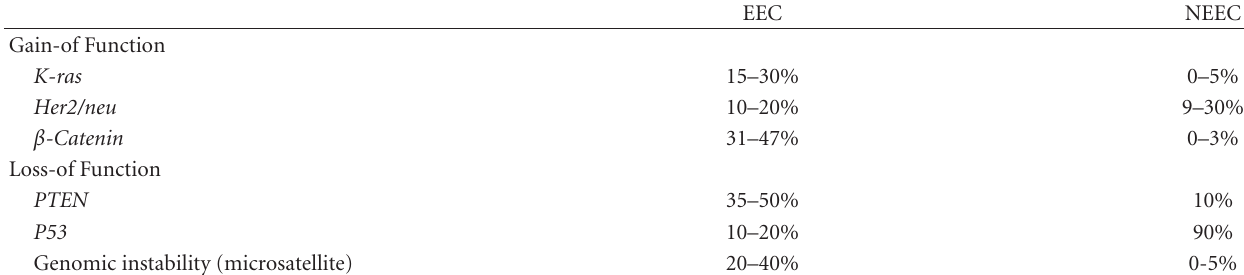
Table 2: Genetics features of endometrial